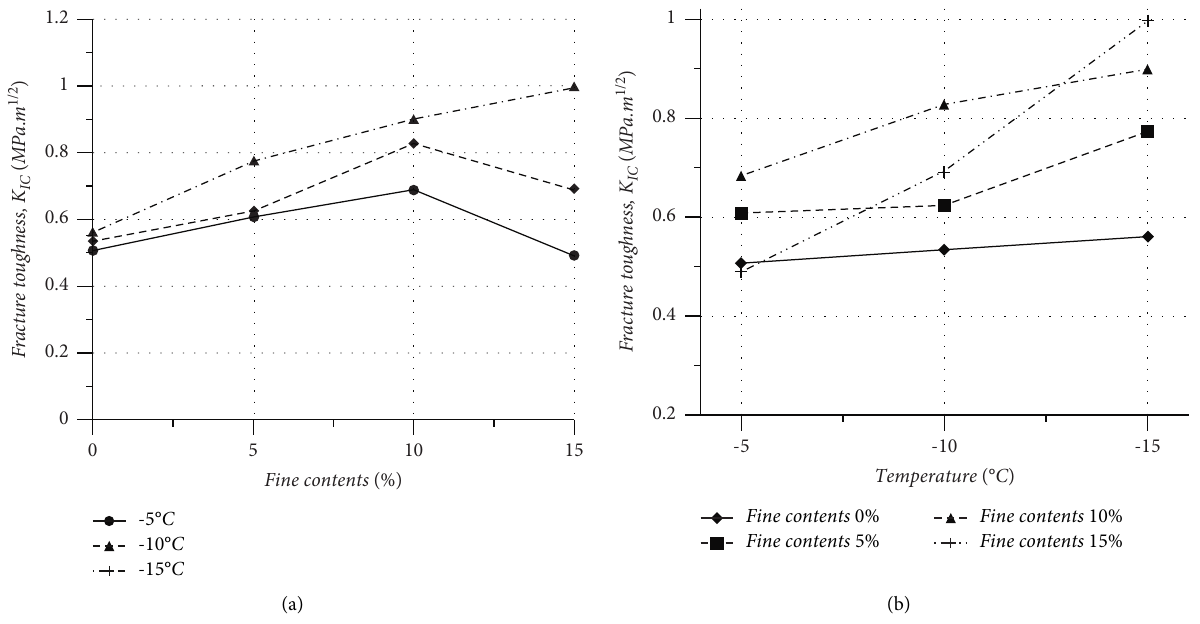
Figure 16: The fracture toughness of the frozen sand specimen with 0, 5, 10, and 15% fine contents at − 5, − 10, and − 15 ° C. (a) Fracture toughness versus fine contents. (b) Fracture toughness versus temperature.